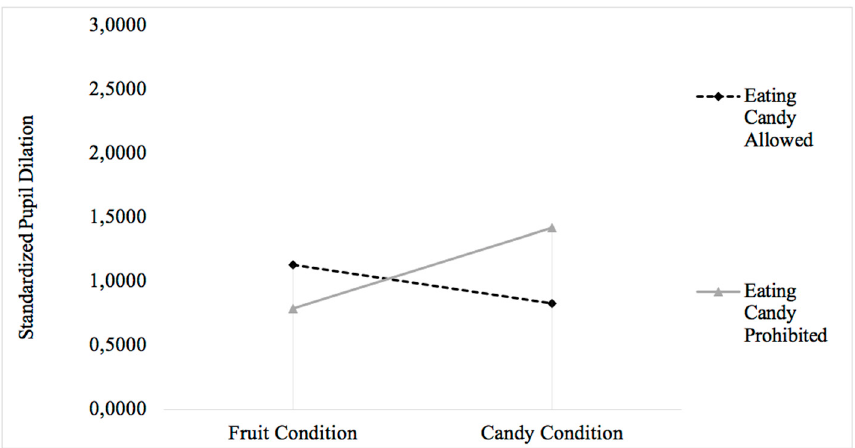
Figure 2. Interaction effect of the experimental conditions and candy prohibition regarding children’s standardized pupil standardized pupil dilation.